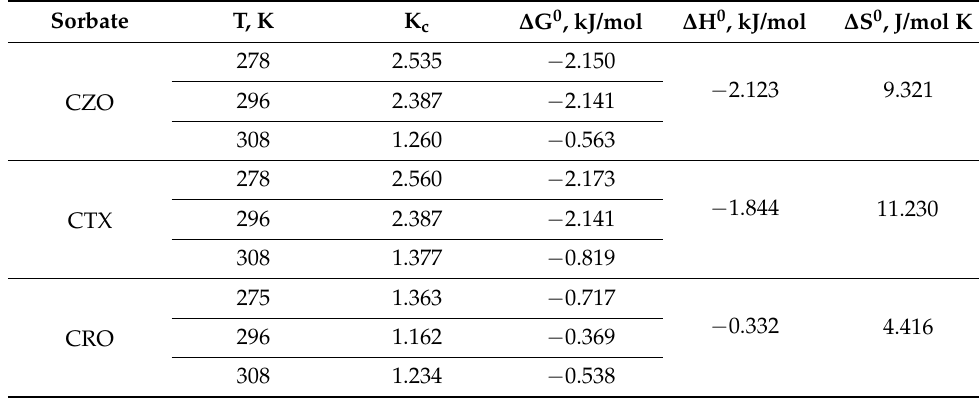
Table 4. Thermodynamic parameters of adsorption of